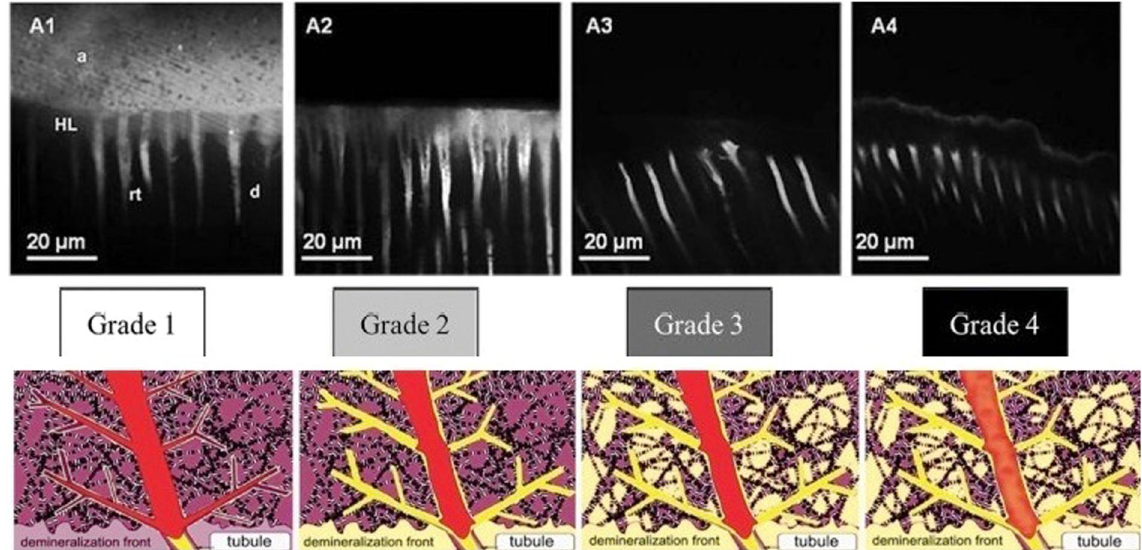
Figure 5. Assessment of Micro permeability: Grade 1: completely intact hybrid layer with no dye reaching it; Grade 2: the dye reaches the base of the hybrid layer; Grade 3: the dye is infiltrated within the hybrid layer completely; Grade 4: the dye is reaching the adhesive